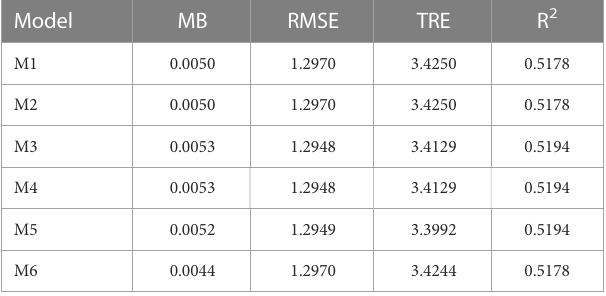
TABLE 3 Fit statistics of the basic